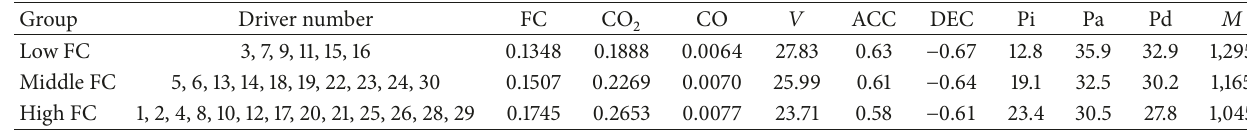
Table 2: Results of driver category by fuel consumption.